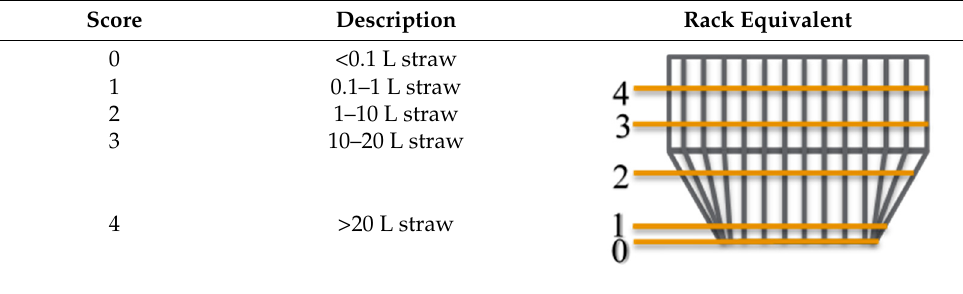
Tail is swollen and has one